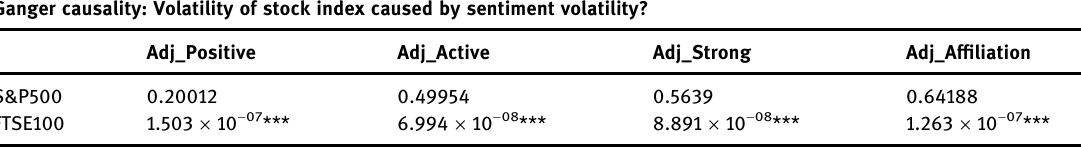
Table 7: F - statistics for the hypothesis H 0 : the sentiment volatility does not Granger cause the asset return volatility Ganger causality: Volatility of stock index caused by sentiment volatility? Adj_Positive